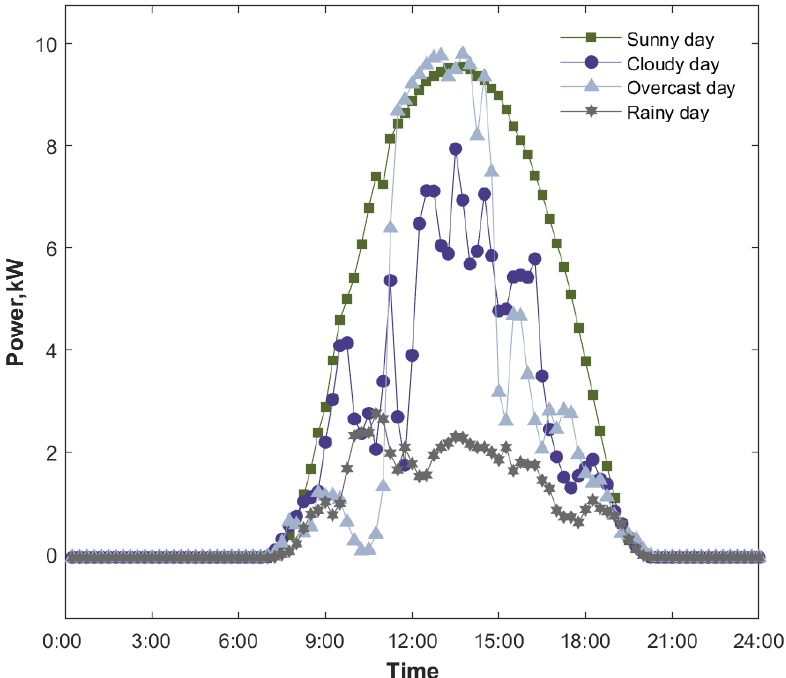
Figure 3. Comparison of actual output power for 4 weather